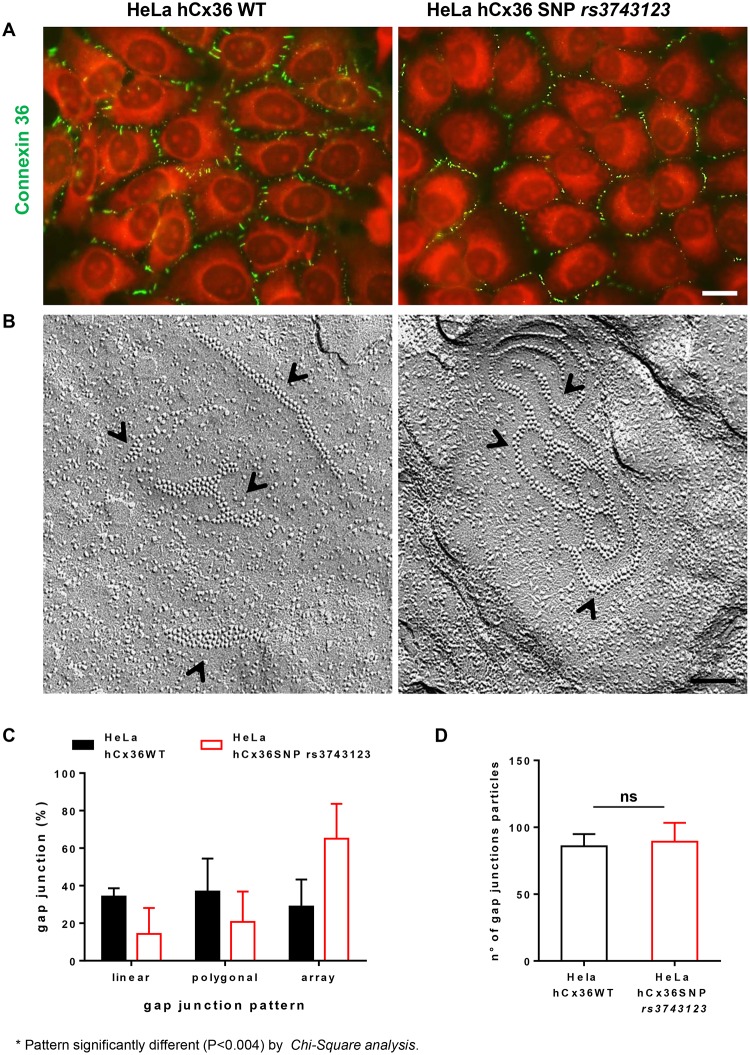
SNP rs3743123 alters the distribution of Cx36 at the cell membrane.A, In HeLa cells stably transfected with the wild type form of Cx36 (left) the protein shows a spotted distribution (green) at the cell membrane. After transfection of the SNP rs3743123 variant (right) the spotted distribution of the protein alternates with regions of continuous membrane staining. Scale bar, 20 μm. B, Freeze-fracture electron microscopy revealed polygonal and array-shaped gap junction plaques (arrow heads) in HeLa cells transfected with either the WT or variant form of Cx36 (right). Scale bar, 85 nm. C, Distribution of different gap junction patterns (polygonal, linear, array shaped) and D, numbers of particles (connexons) per plaque in HeLa cells transfected with the wild type (n = 37) and SNP rs3743123 forms of Cx36 (n = 48). Images and mean + SEM data are from three independent clones stably expressing either the wild type or the SNP rs3743123 form of the protein.